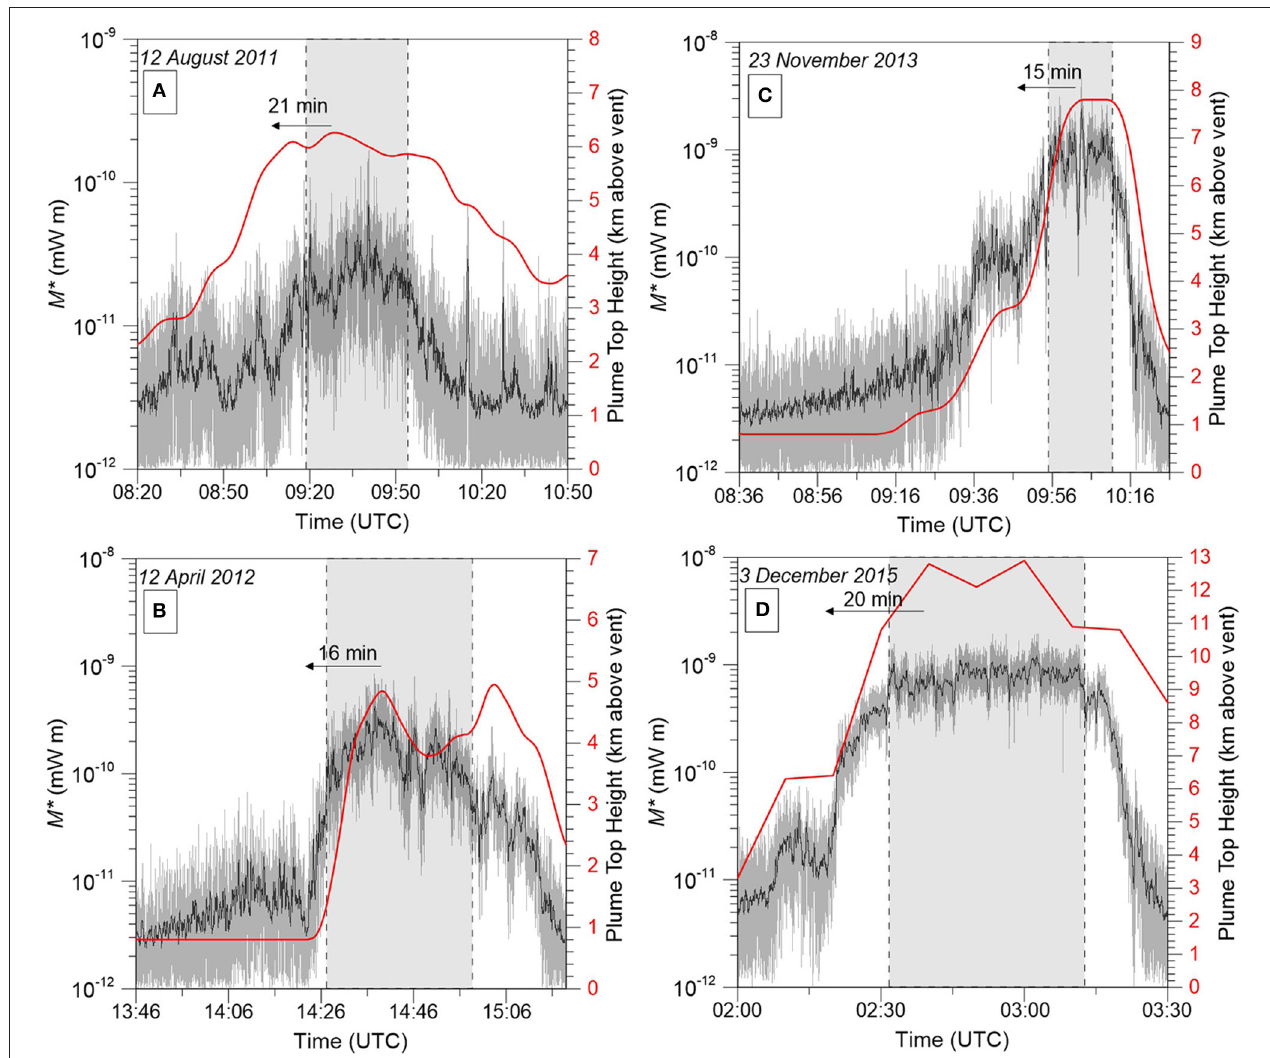
FIGURE 6 | Radar Mass proxy ( M *) (raw data in gray; 12-s running average in black) and plume top height (red curve) variations with time during (A) 12 August 2011 (Scollo et al., 2015), (B) 12 April 2012, and (C) 23 November 2013 NSEC paroxysms, and (D): 3 December 2015 VOR paroxysm. Plume top heights were measured by visible imagery during the 2011–2013 paroxysms and by X-band weather radar observations during the 3 December 2015 ( Vulpiani et al., 2016). Gray areas indicate climax